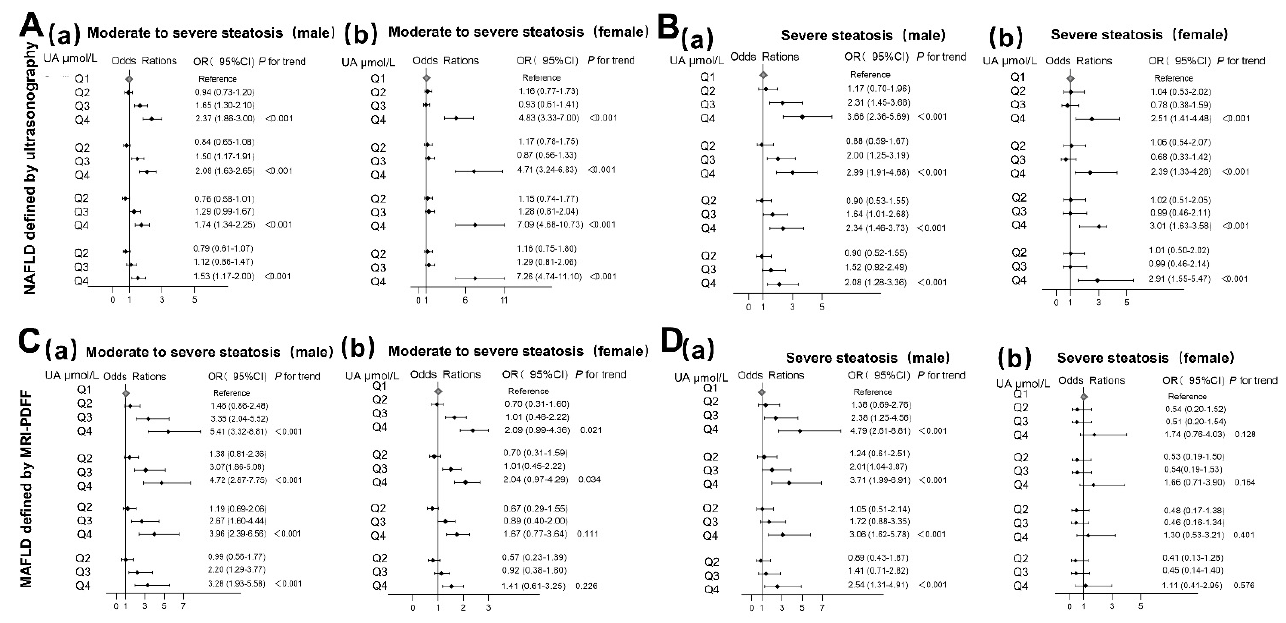
Figure 1. Serum uric acid odds ratio (OR) (95% confidence interval (CI)) for steatosis severity in male ( n = 2345) and female ( n = 1192) ultrasound-diagnosed NAFLD patients: ( A ) moderate-to-severe steatosis in males ( a ) and females ( b ); ( B ) severe steatosis in males ( a ) and females ( b ). Serum uric acid odds ratio (OR) (95% confidence interval (CI)) for steatosis severity in male ( n = 767) and female ( n = 250) MRI-PDFF-diagnosed MAFLD patients: ( C ) moderate-to-severe steatosis in males ( a ) and females ( b ); ( D ) severe steatosis in males ( a ) and females ( b ).